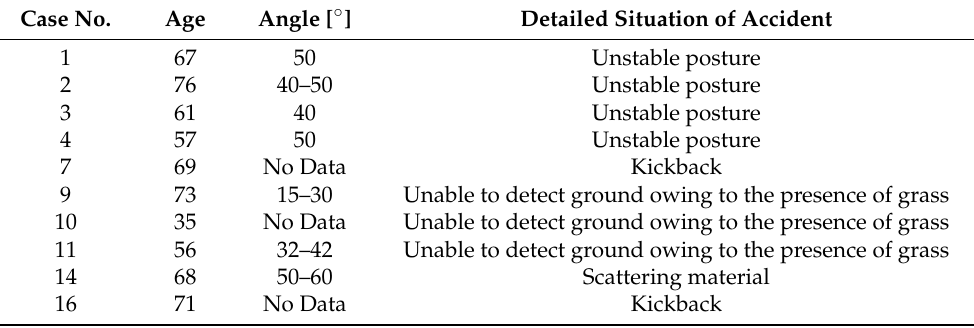
Table 1. Grass cutting accidents on slopes (based on interview studies [16]). Case